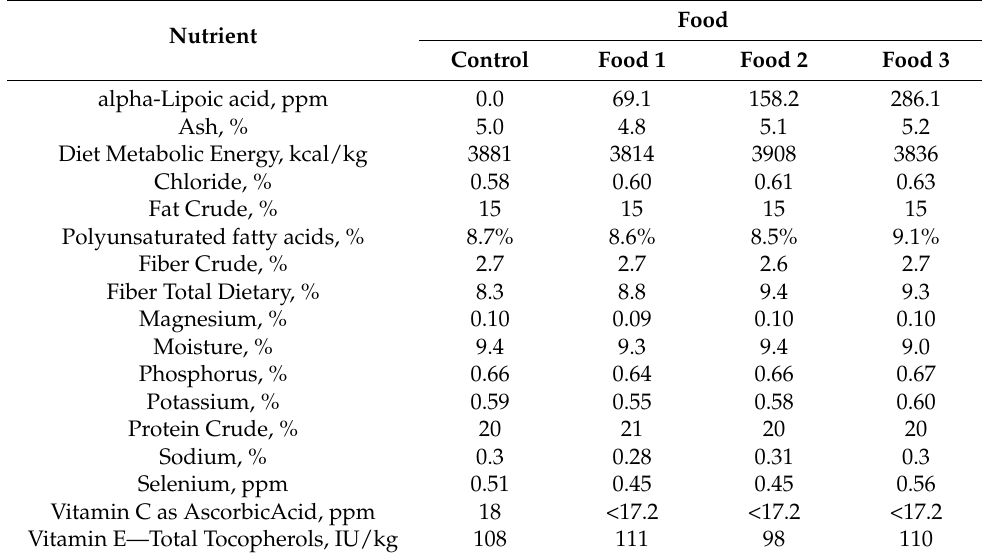
Table A2. Nutritional composition of the study foods on an As is basis. Control, Food 1, Food 2 and